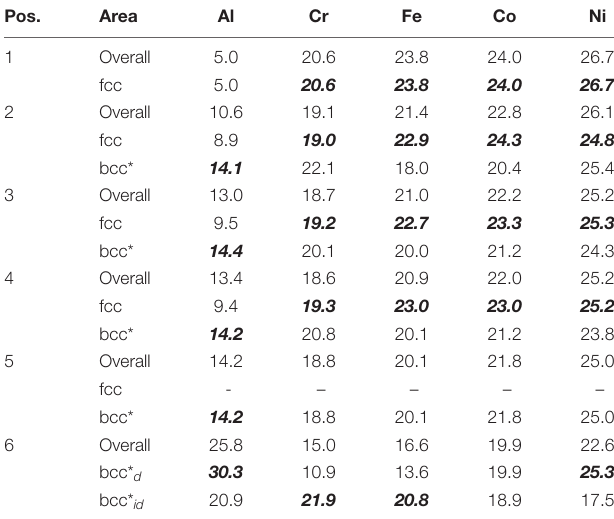
TABLE 3 | Representative EDS analysis of the major microstructures of the as-built samples (at%). Pos.